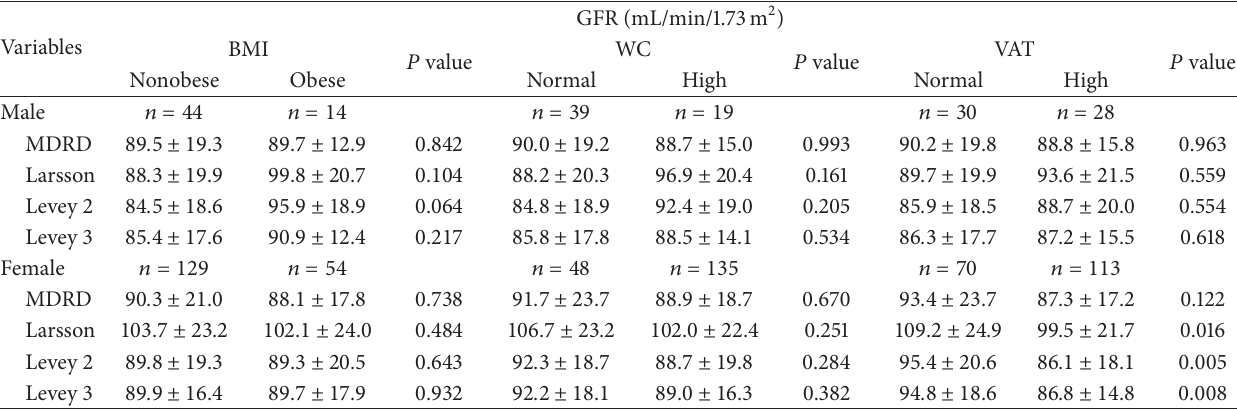
Table 3: Glomerular filtration rate estimated by the modification of diet in renal disease, Larsson, Levey 2, and Levey 3 equations by categories of body mass index, waist circumference, and visceral adipose tissue. GFR (mL/min/1.73m 2 ) Variables BMI 𝑃 WC 𝑃 VAT 𝑃 value value value Nonobese Obese Normal High Normal